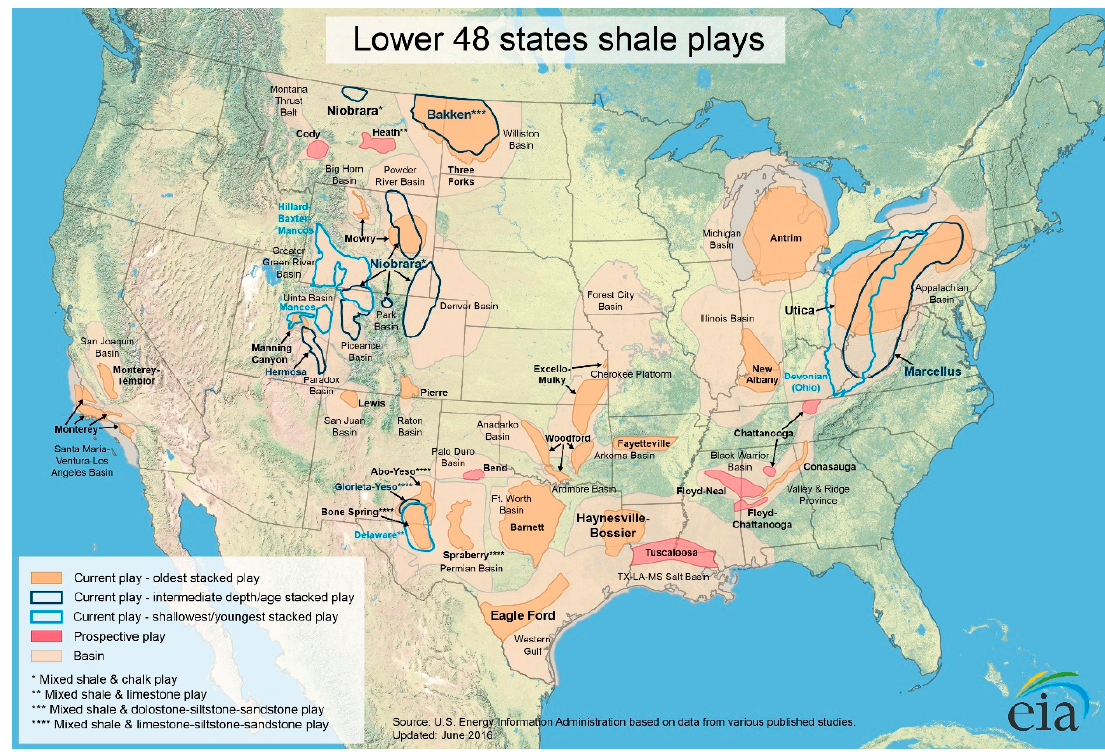
Figure 1. Shale development areas across the USA. The map shows currently drilled and prospective shale layers and depicts regions that have overlapping or stacked shale layers residing at different depths [51].